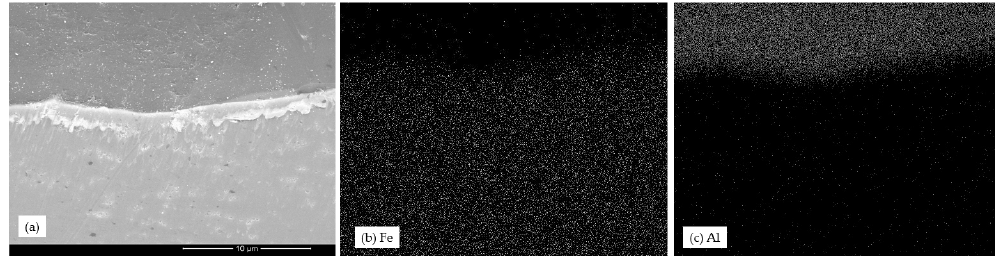
Figure 5. ( a ) Energy dispersive spectroscopy (EDS) image, ( b ) Fe element distribution, and ( c ) Al element distribution.